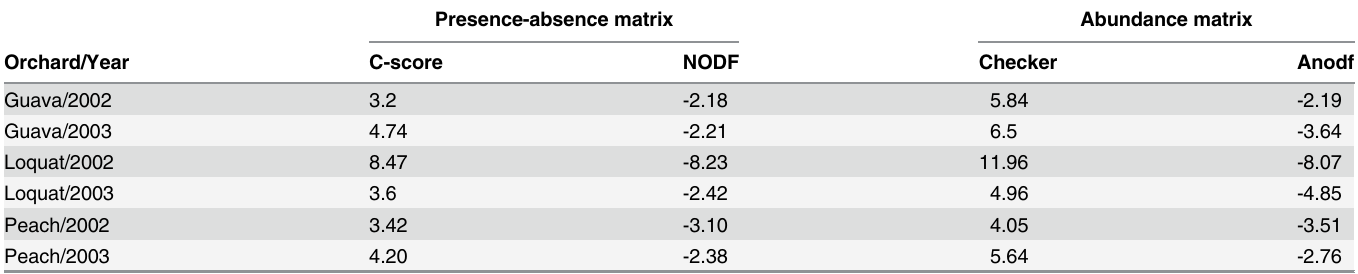
Table 3. Z-scores for null model analyses of presence-absence and abundance matrices of fruit flies in 3